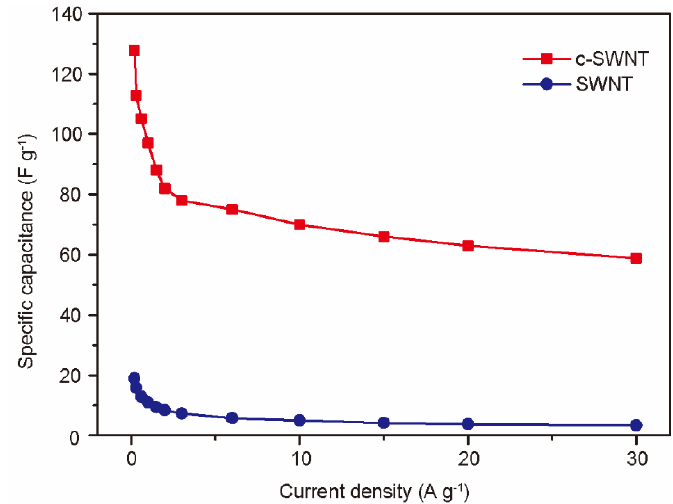
Figure 7. The rate capabilities of SWNT and c-SWNT electrodes at current densities from 0.2 to 30 A g −1 .